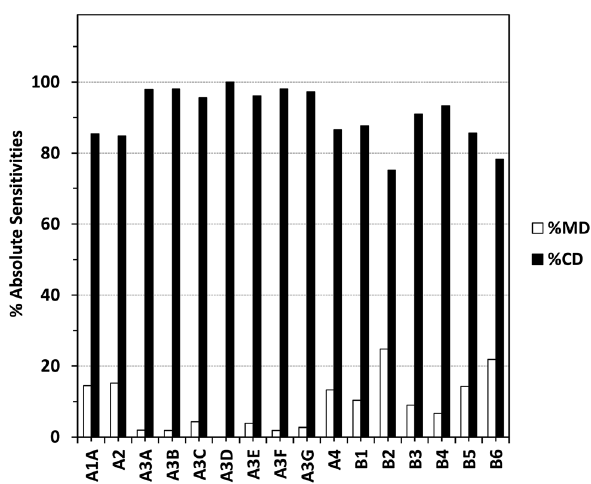
Figure 2: The percent AS vs. correctly diagnosed (%CD) and mis- diagnosed(%MD)BCpatientsplot,atdifferentstagesofthedisease were determined using MM and FNB (CNB)